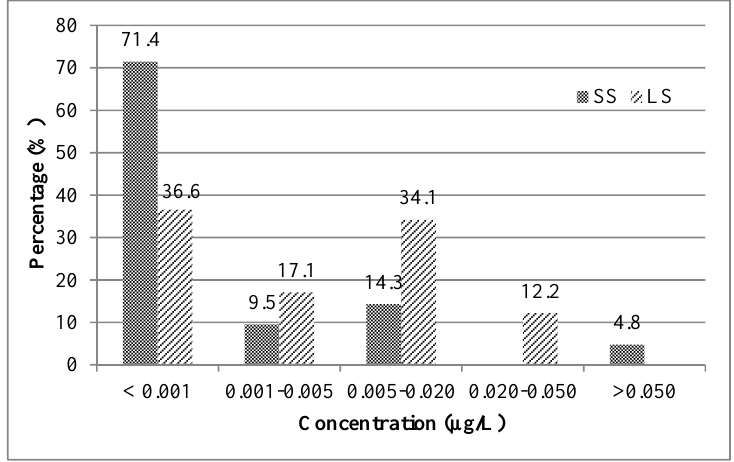
Figure 1. Relative frequency distribution (%) of ochratoxin A in small- (SS, n = 42) and large-scale (LS, n = 41) brewed beer.